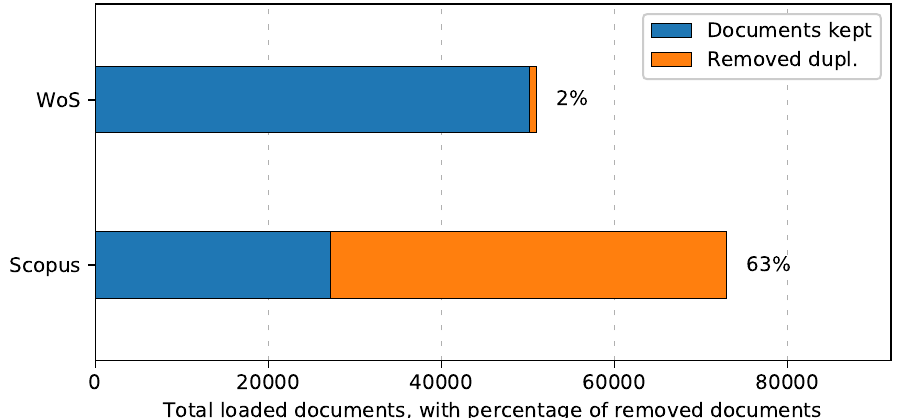
Figure 2. Field Programmable Gate Array (FPGA) total loaded documents from Clarivate Web of Science (WoS) and Scopus databases, with the percentage of removed documents after duplication removal filter.